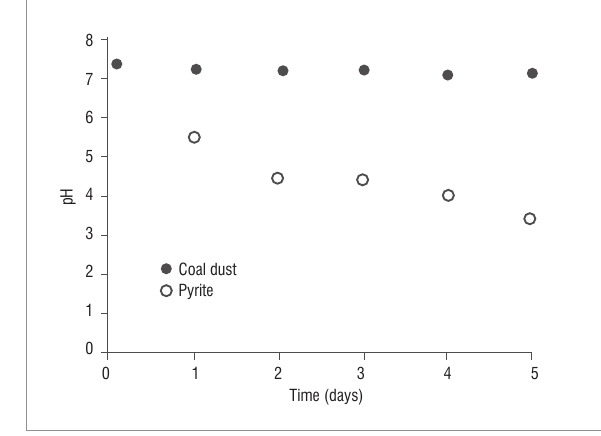
Figure 11: Diagram showing the rate of acid generation by coal dust and pyrite.